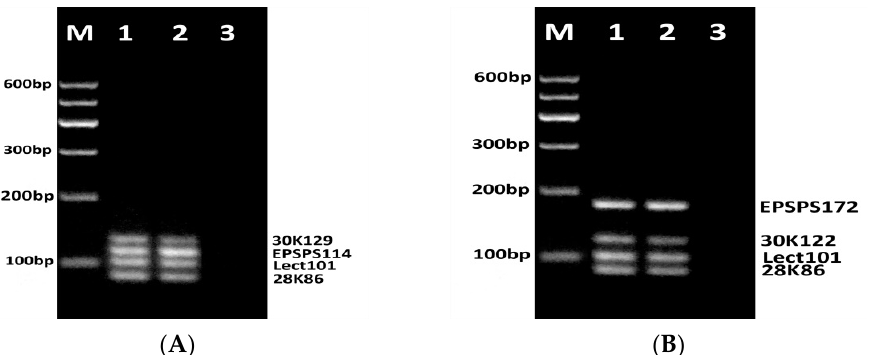
Figure 3. Fourplex PCRs for detection of GM Soybean allergens lectin, Gly m Bd 28K, Gly m Bd 30K and epsps using primer pairs lect135f/lect135r, 28K86f/28K86r, 30K122f/30K122r, ep- sps172f/epsps172r (N2) (lanes 1–3) and lect135f/lect135r, 28K98f/28K98r, 30K118f/30K118r, ep- sps172f/epsps172r (N1) (lanes 4–6). Samples: lanes 1, 4. CRM 1% RRS; lanes 2, 5. CRM 10% RRS, lanes 3, 6. water (negative control). M . Molecular weight marker (Qiagen GelPilot 100 bp ladder).